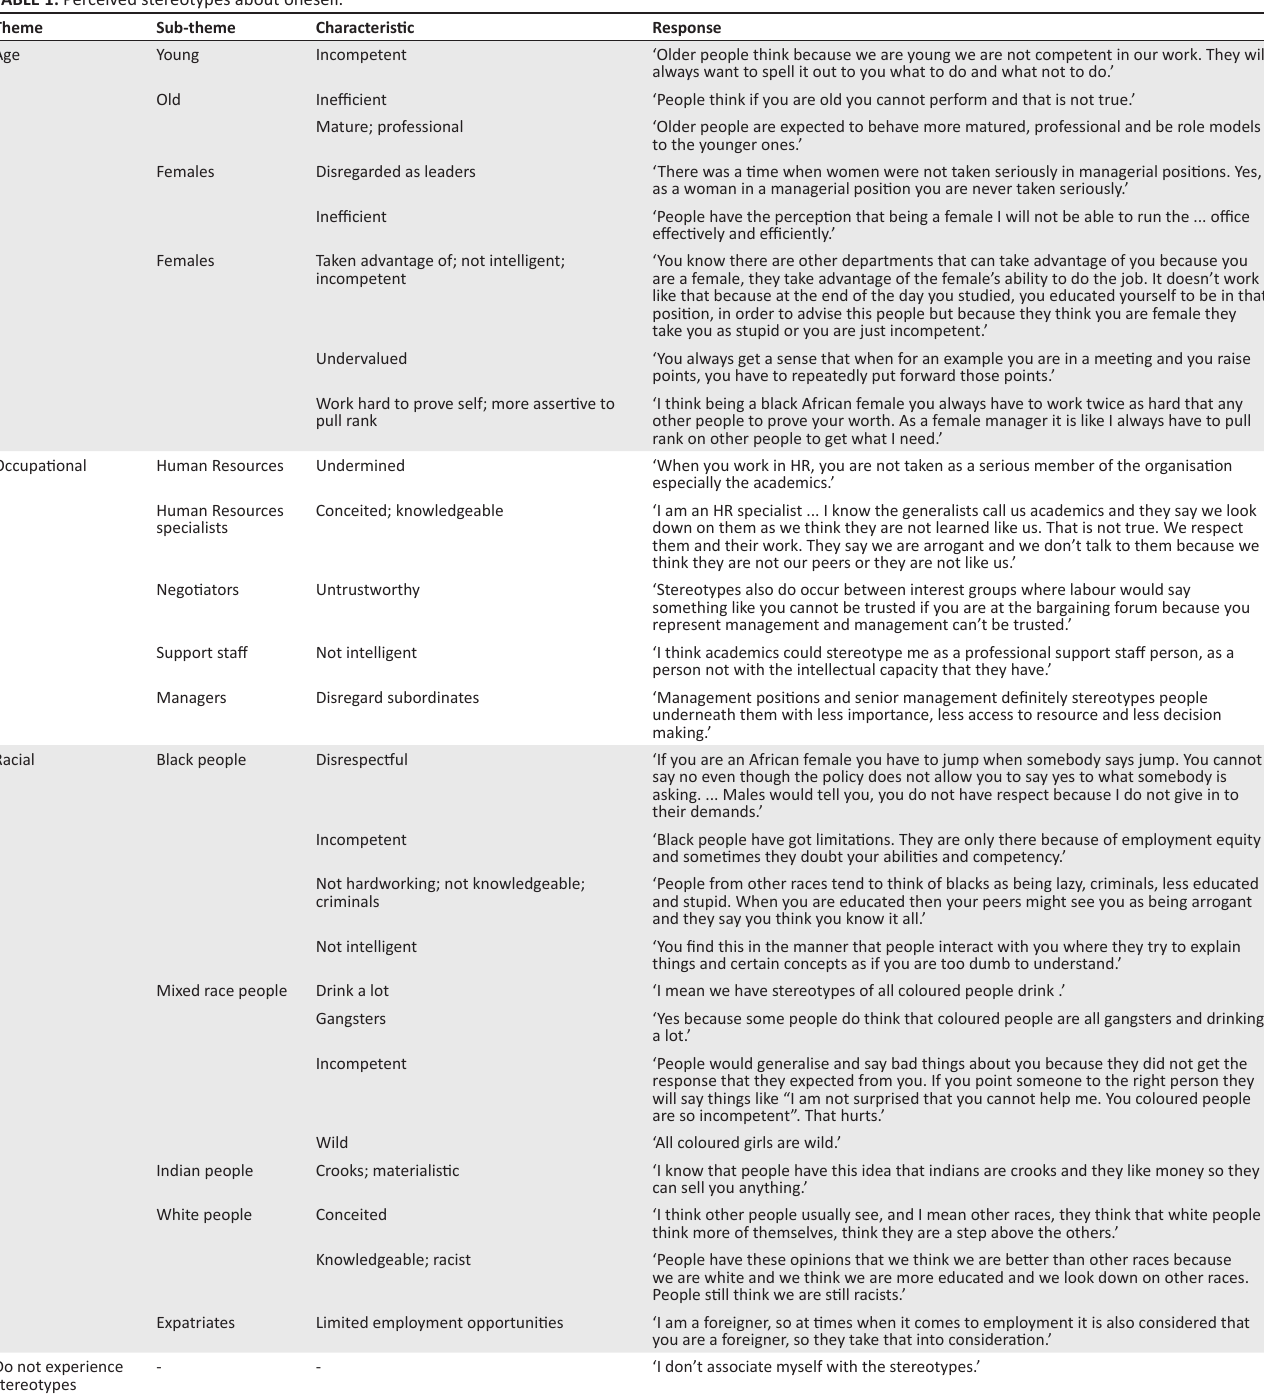
TABLE 1: Perceived stereotypes about oneself. Theme